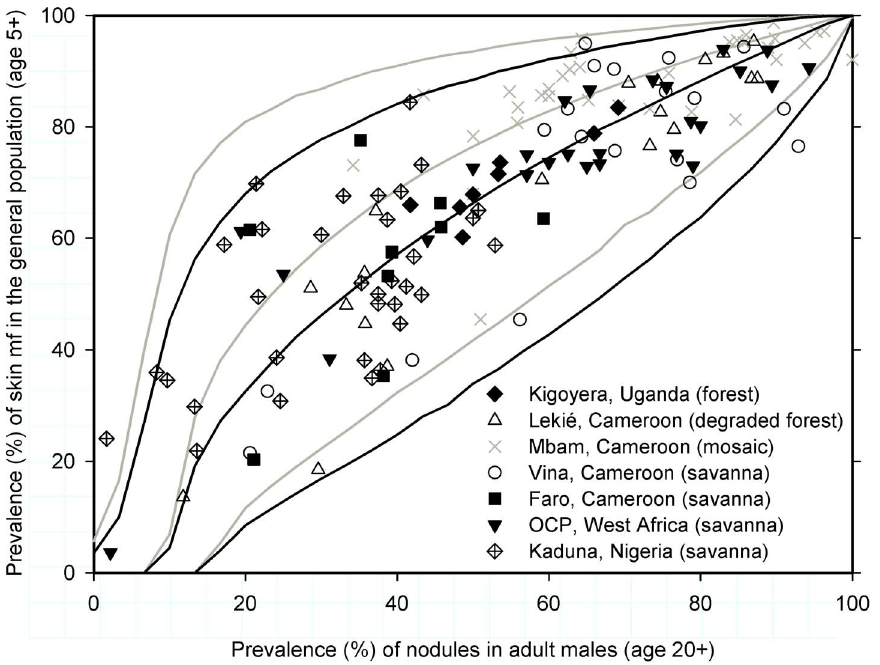
Figure 3. Predicted skin mf prevalence in the general population, given observed nodule prevalence in adult males. Symbols represent observed data by geographical area. Within each set of regression lines, the middle and outer lines relate to the median and 95% Bayesian credible intervals of the posterior predictive distribution, respectively (black set for areas all areas but Mbam; grey set for Mbam, the only forest- savanna mosaic area). Predictions were made assuming that nodule prevalence was based on a sample of 30 adult males.